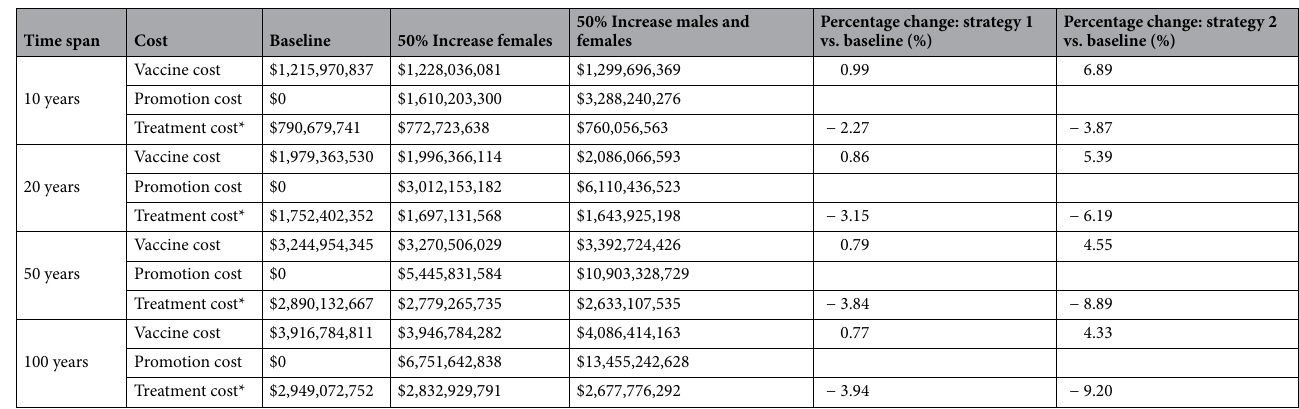
Table 2. Short-term to long-term costs under different scenarios. (1) Discount rate is 0.03; (2) Costs reported in 2018 USD; (3) Female and male vaccination includes age 13 to 26